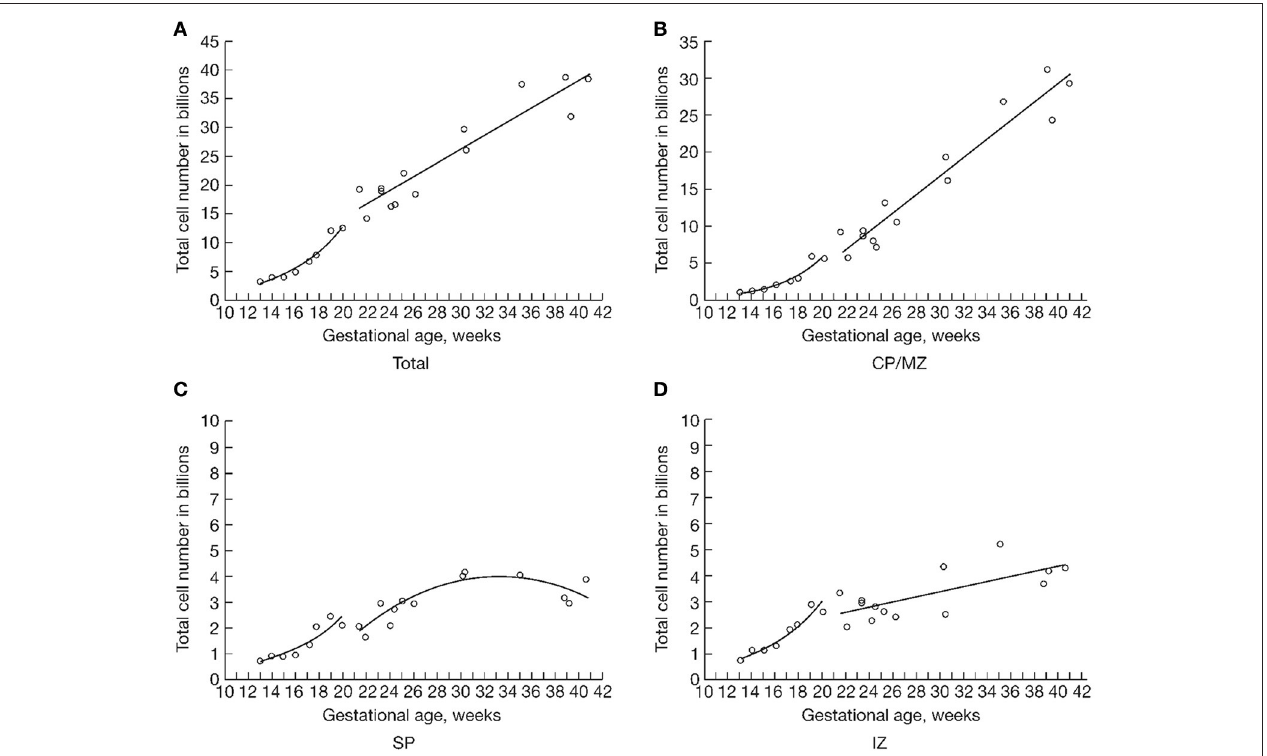
FIGURE 5 | “The total number of cells in billions (10 9 ) in three major developmental zones of the human fetal forebrain (B,C,D) (CP/MZ, SP, IZ) and in the summation of all four zones (A) (CP/MZ, SP, IZ, VZ/SVZ), representing the total number of cells in the entire human fetal forebrain. The material has been allocated into two study periods: one from 13 to 20 weeks of gestation and another from 22 weeks of gestation to term. Due to the limited number of cases during the period from 18 to 22 weeks of gestation, we could not determine which of the two mathematical models that gave the best fit in that transitional interval.” Reproduced with permission from Samuelsen et al.